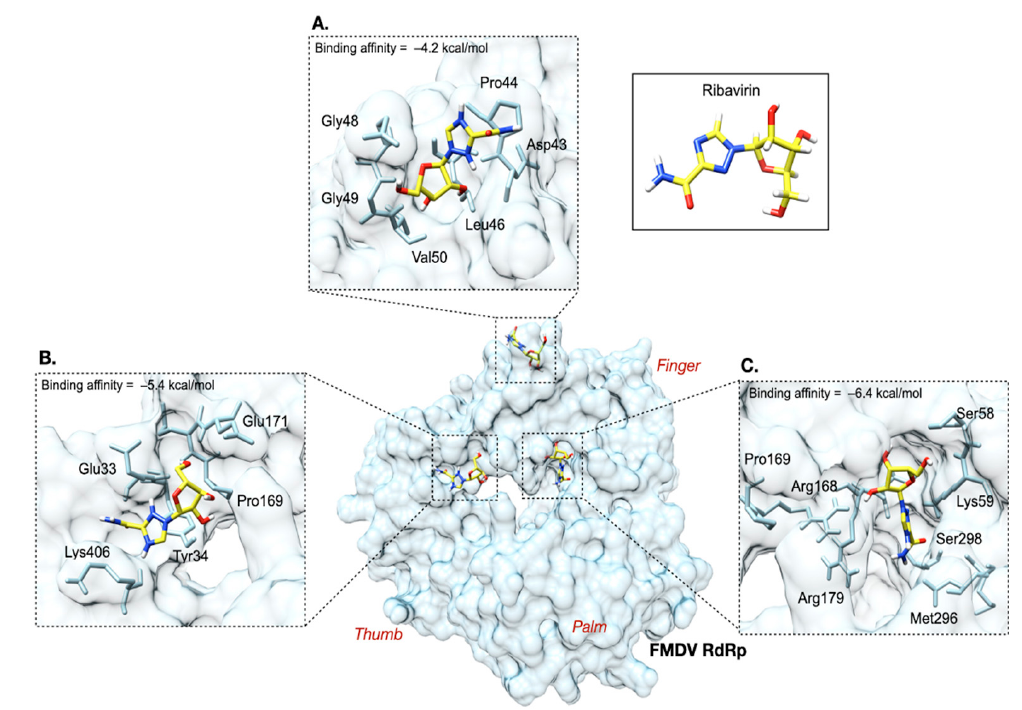
Figure 7. Molecular docking of ribavirin onto the three-dimension structure of FMDV O189 RdRp using AutoDock Vina algorithm in PyRx 0.9.8. The ribavirin molecule is displayed as a yellow stick. The backbone of ribavirin interactive residues within the RdRp is light blue. The insets show the binding of ribavirin to the potential residues. For specific docking, ribavirin reacted to Pro44 and Pro169 with the binding affinities of − 4.2 kcal/mol ( A ) and − 5.4 kcal/mol ( B ), respectively. In the random docking, ribavirin was preferentially buried in the deep pocket in which Met296 resided with the binding affinity of − 6.4 kcal/mol ( C ). Notes: white, blue, and red sticks represent hydrogen, nitrogen, and oxygen, respectively.